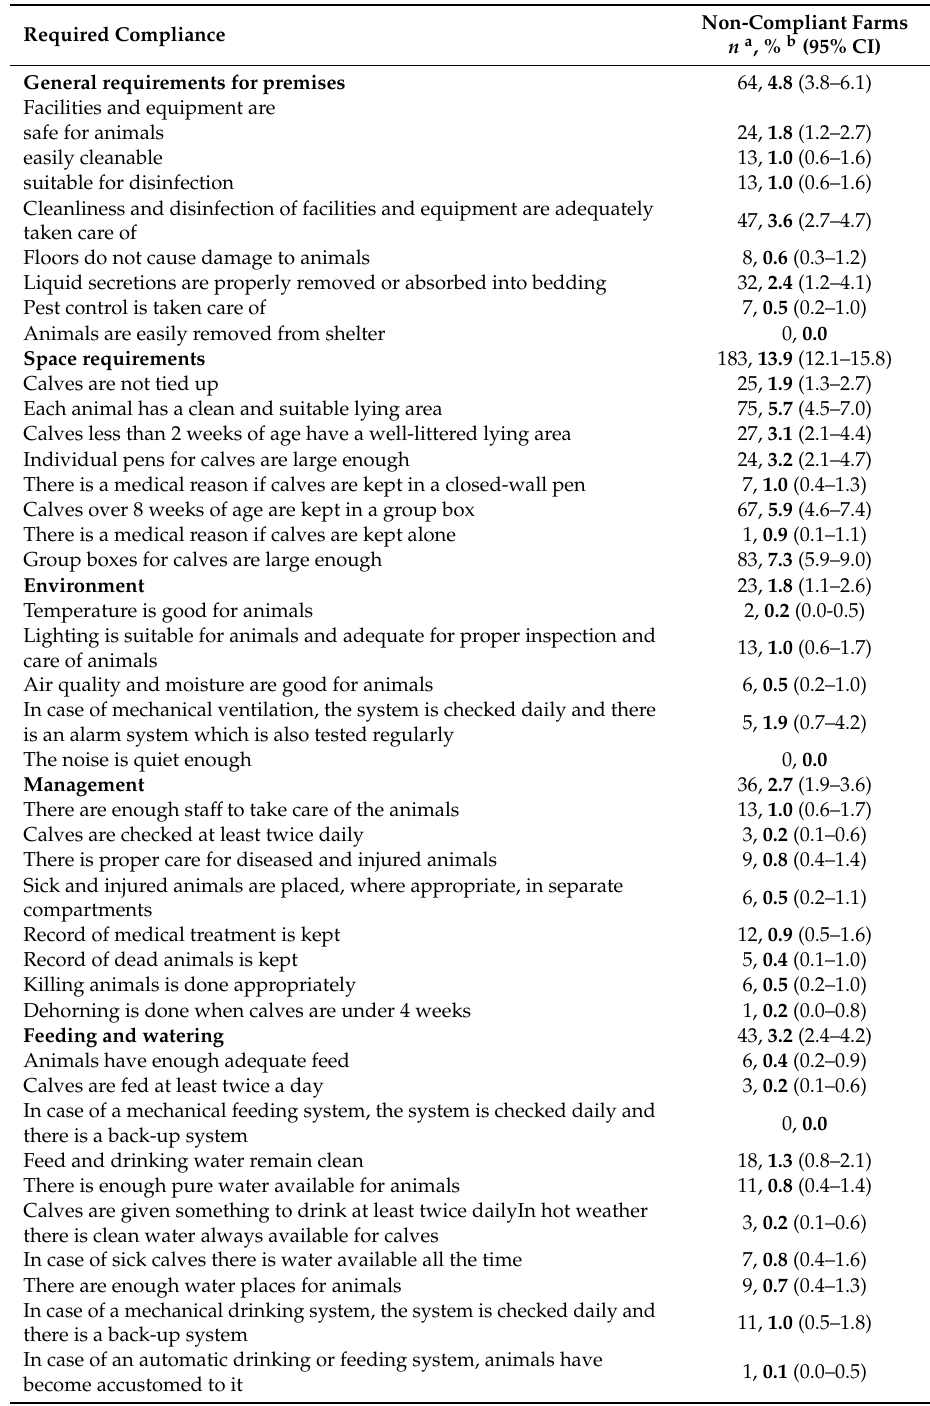
Table 2. Prevalence of cattle farms not complying with the main welfare categories or the checklist requirements concerning